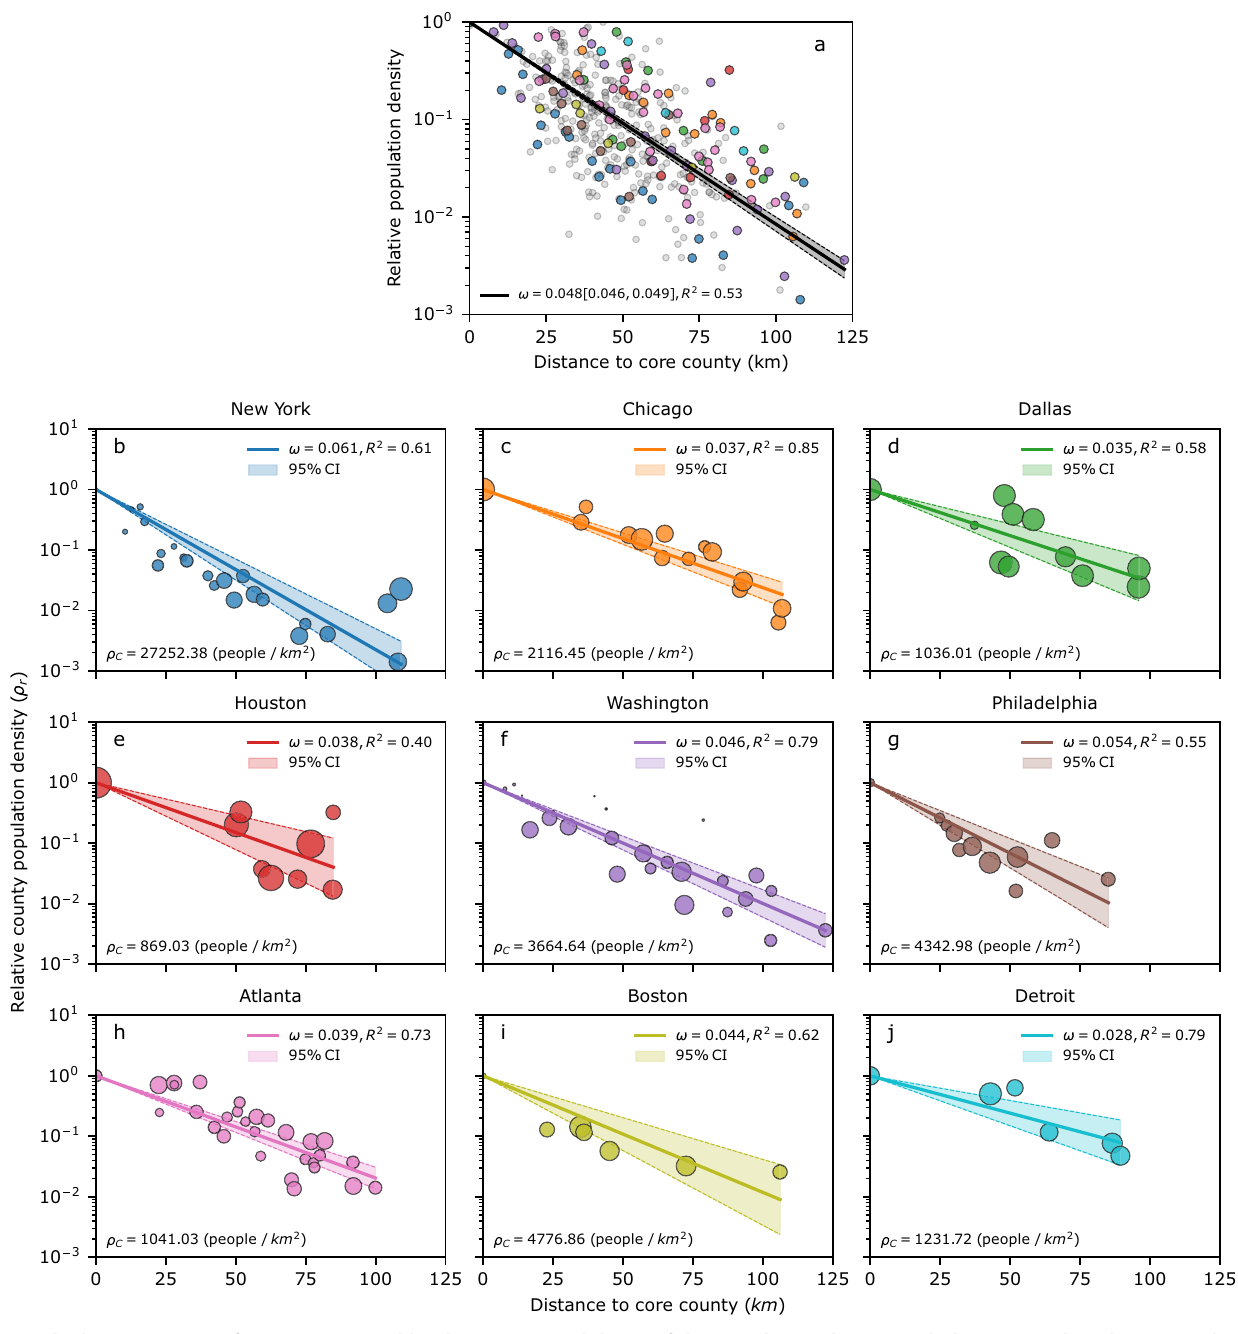
Fig. 4 The heterogeneity of cities is captured by the exponential decay of the population density with distance. a The relative population density ( ρ r ), given by county ’ s population density scaled to that of the core county ( ρ C ), as function of distance from the core county ( d r ). Colored dots represent the top nine most populous cities with more than fi ve counties, shown in detail in b – j , and gray dots represent the remaining 37 metro areas. The relative density ρ r can be approximated by the exponential function ρ r (cid:4) e (cid:2) ω d r , in which ω and R 2 are indicated in the panels. In b – j , the size of the dots are proportional to the land area of the